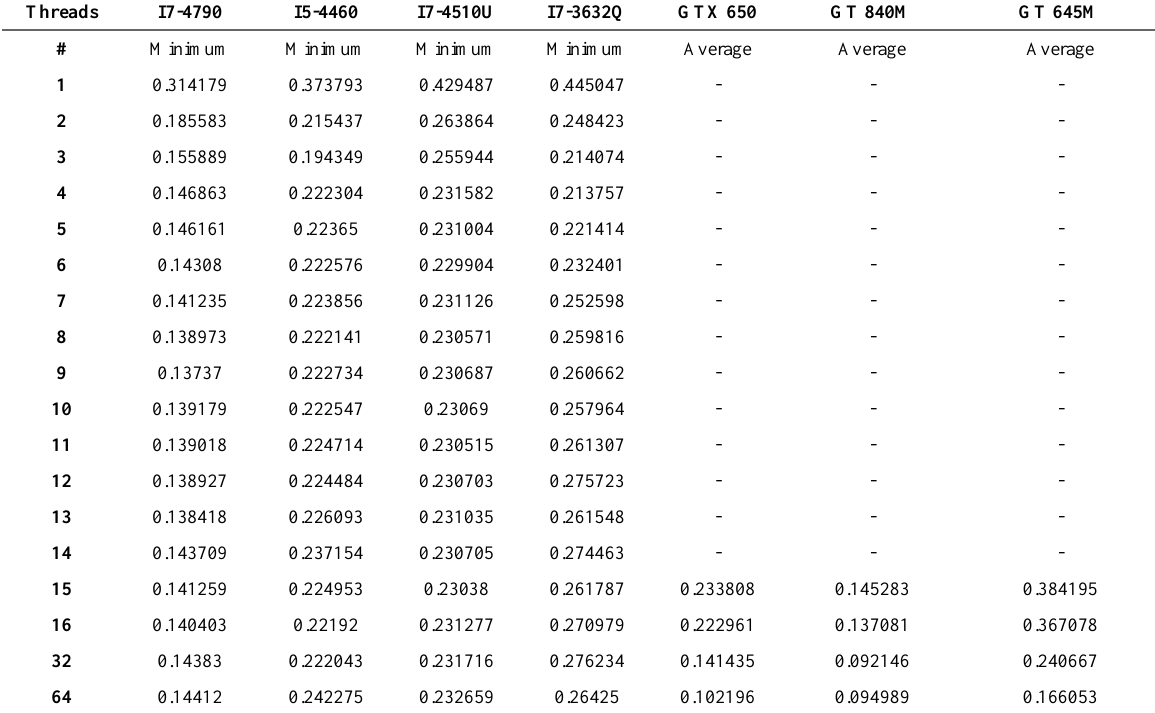
Table 4 . Time consumed for image generation in 720p (in seconds) for CPU and